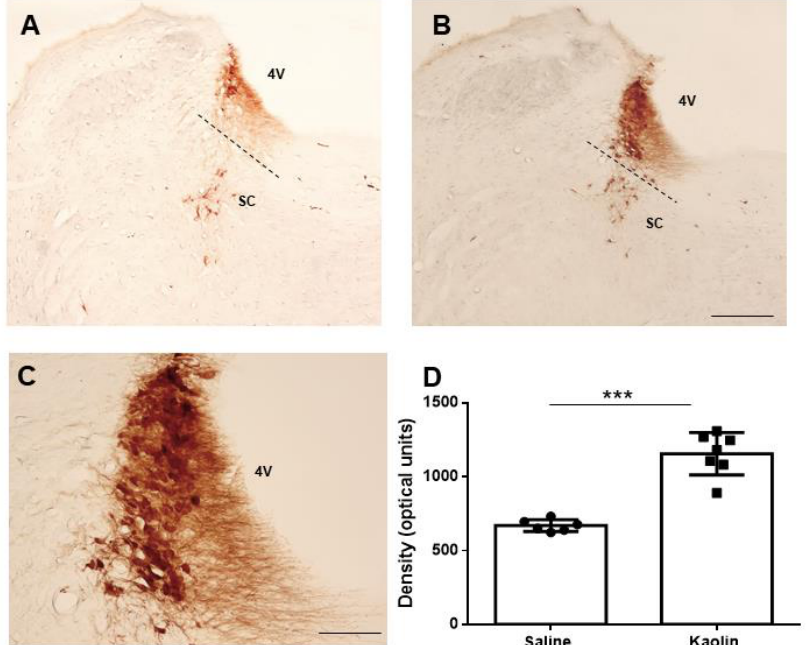
Figure 2. Expression of the TH at the LC. Representative photomicrographs of TH-immunolabelling in saline- and kaolin-injected animals are depicted in ( A , B ), respectively, from sections collected at approximately 0.80 mm caudal to the interaural line ( − 0.8 mm). The TH-immunoreactive neurons of the subcoerular area (SC), which is separated from the LC by the dashed line, are easier to identify but they were not counted in the present study. At the most dorsal part of the LC, individual TH- immunoreactive neurons are harder to identify due to the higher density of fibers (inset in ( C ), which is a higher magnification of ( B )). By densitometric analysis, which analyzed both cell bodies and fibers without distinction, kaolin-injected animals presented a significant increase in TH optic density at the LC ( D ). Saline n = 6; Kaolin n = 7. Scale bar in ( B , C ): 1mm and 100 µm, respectively; ( A , B ) are at the same magnification. Data in ( D ) are presented as means ± SEM. *** p < 0.001.